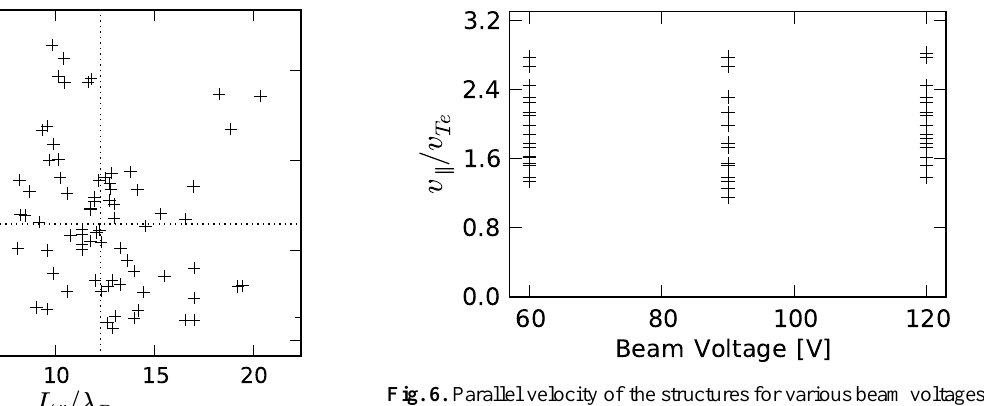
Fig. 6. Parallel velocity of the structures for various beam voltages.